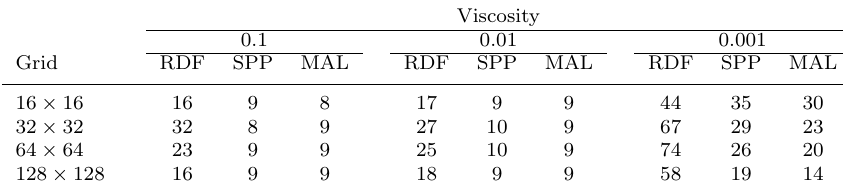
Table 4. Number of GMRES(20) iterations with the RDF, MAL and SPP precondition- ers for steady Oseen problems (Q2-Q1 FEM, stretched grids), the parameters τ , α , γ are respectively obtained by Fourier